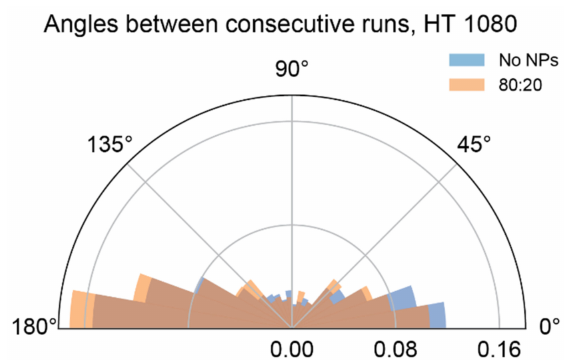
Figure A4. Distribution of turning angles between consecutive active runs in HT 1080